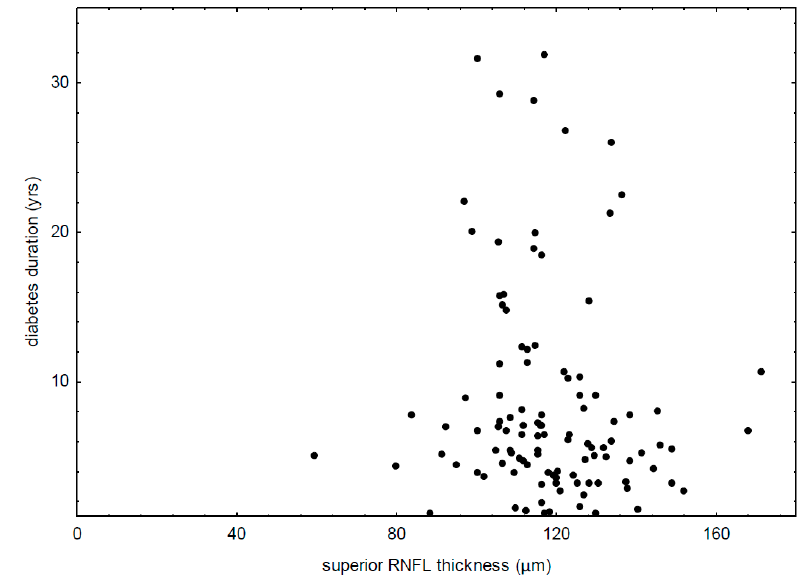
Figure 2. Correlation between thickness of superior retinal nerve fiber layer and duration of type 1 diabetes (R = − 0.20, p = diabetes (R = − 0.20, p = 0.0336).